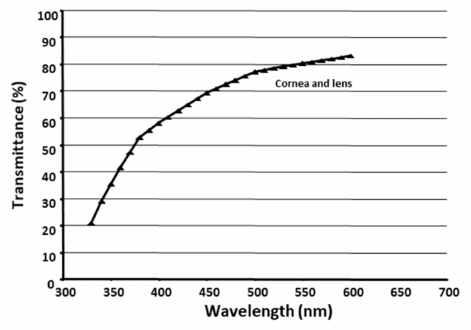
Figure 6. Spectral transmittance of the rat corneas and lenses. Values calculated from the transmit- tance of the corneas [41] and lenses